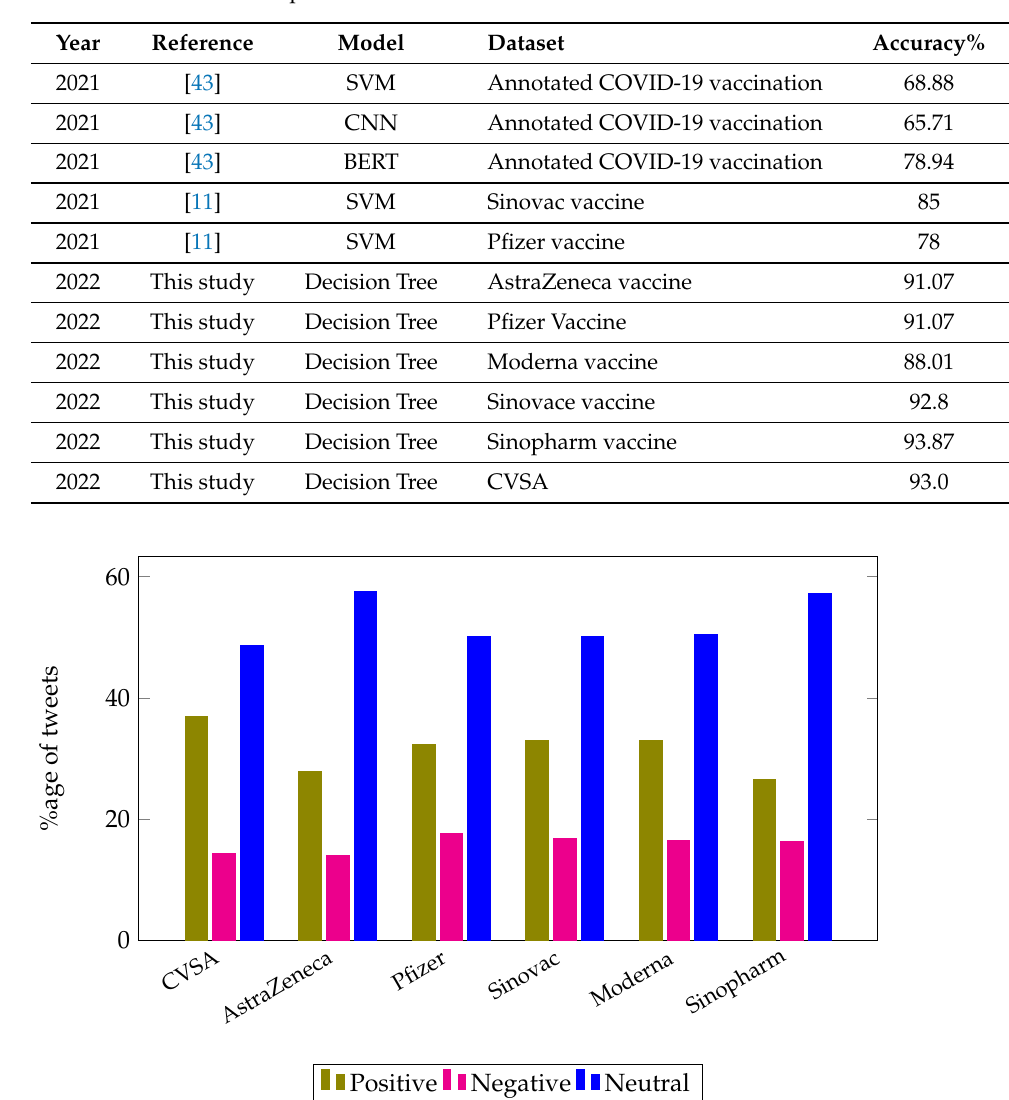
Table 9. Performance comparison with the state-of-the-art research.